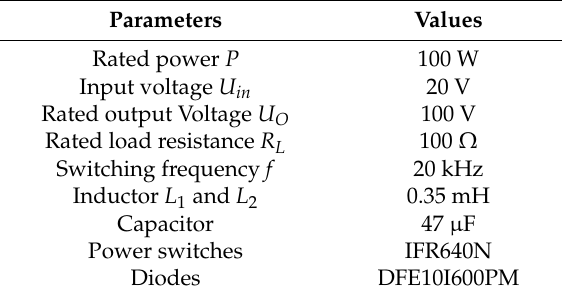
Table 3. Design parameters of the converter.